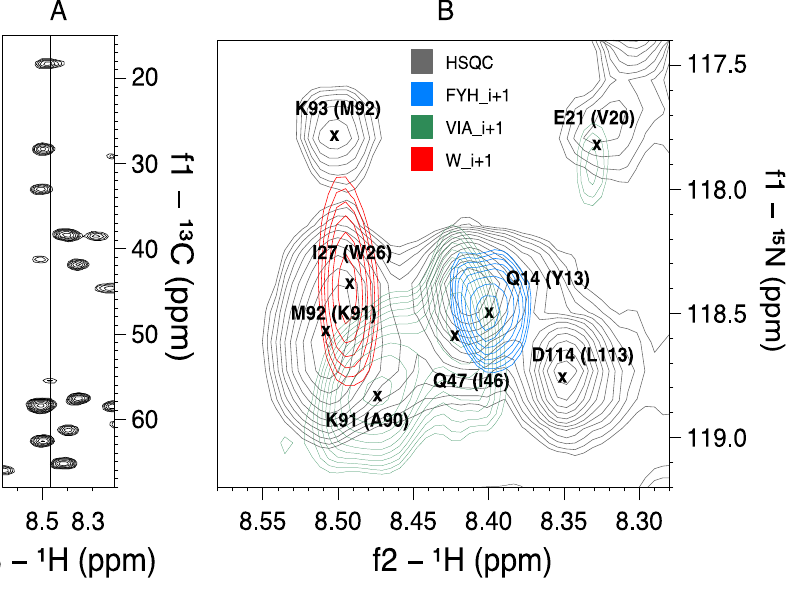
Figure 2. The significance of MUSIC experiments in an overlap region of a medium-sized protein. Panel ( A ) shows parts of the CBCA(CO)NH-plane of R17 at 118.5 ppm ( 15 N). This is the region with the most shift redundancy in the 15 N HSQC spectrum. ( B ) The superposition of HSQC and three MUSIC spectra illustrates how the latter can assist the identification of spin partners in the CBCA(CO)NH spectrum. For instance, the VIA_i+1 peak at approximately 8.47 ppm ( 1 H) can easily be identified from the CBCA(CO)NH spectrum as an alanine successor (highlighted in a ). The identity of the peaks and their predecessors are included in the HSQC